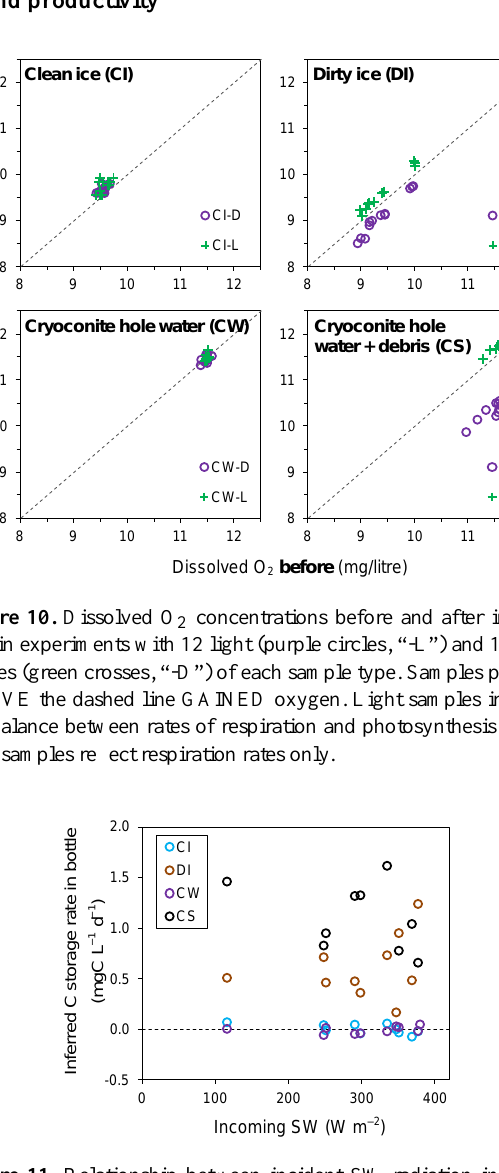
Figure 11. Relationship between incident SW radiation intensity and inferred C storage rate by photosynthesis, for clean ice (CI, blue), dirty ice (DI, brown), cryoconite holes (CH, black) and cry- oconite hole water (CW,